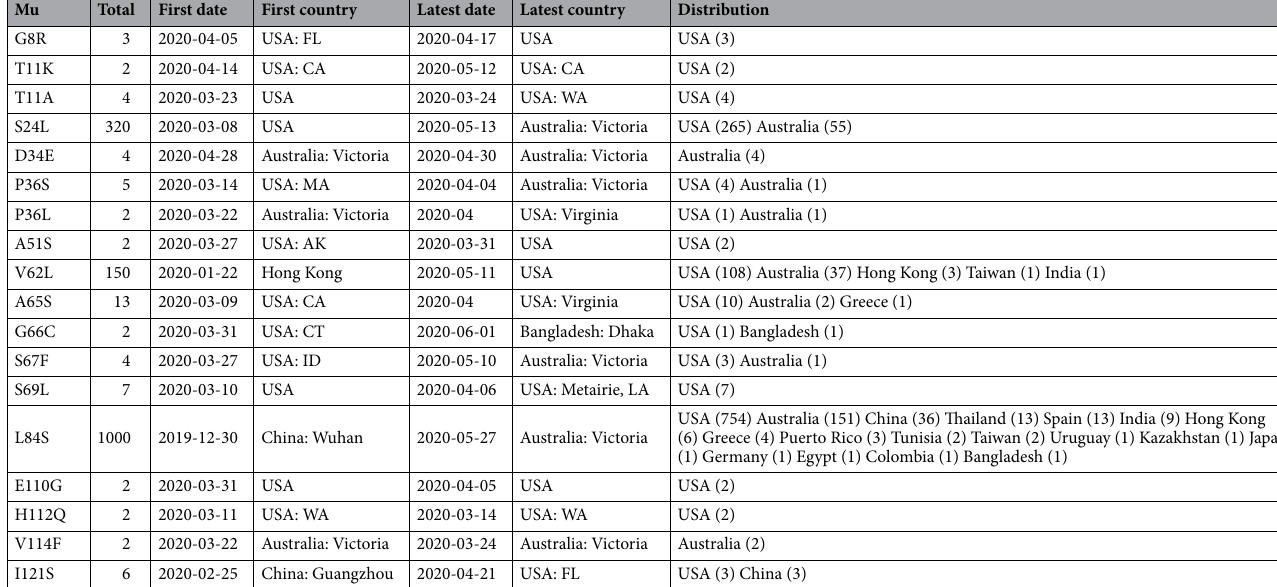
Table 8. Gene ORF8—nonsynonymous mutations occurring in 2 or more sequences.